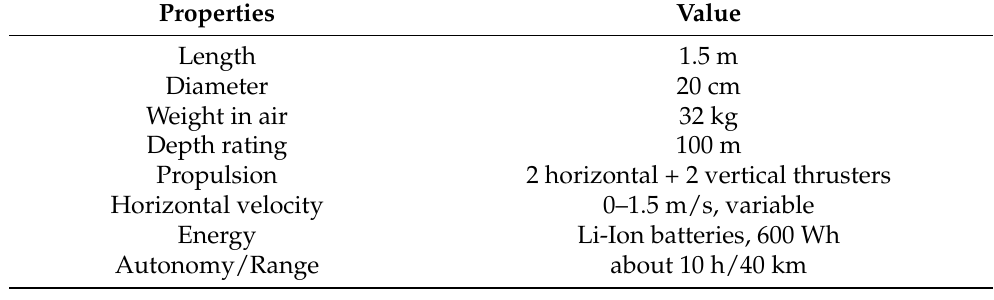
Table 3. MARES parameters.